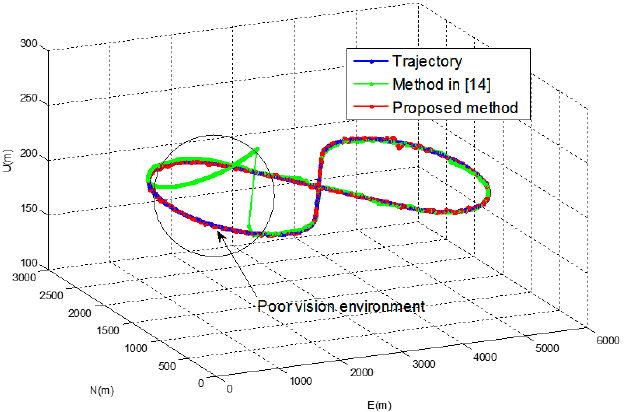
Figure 6. Navigation results of the simulation.